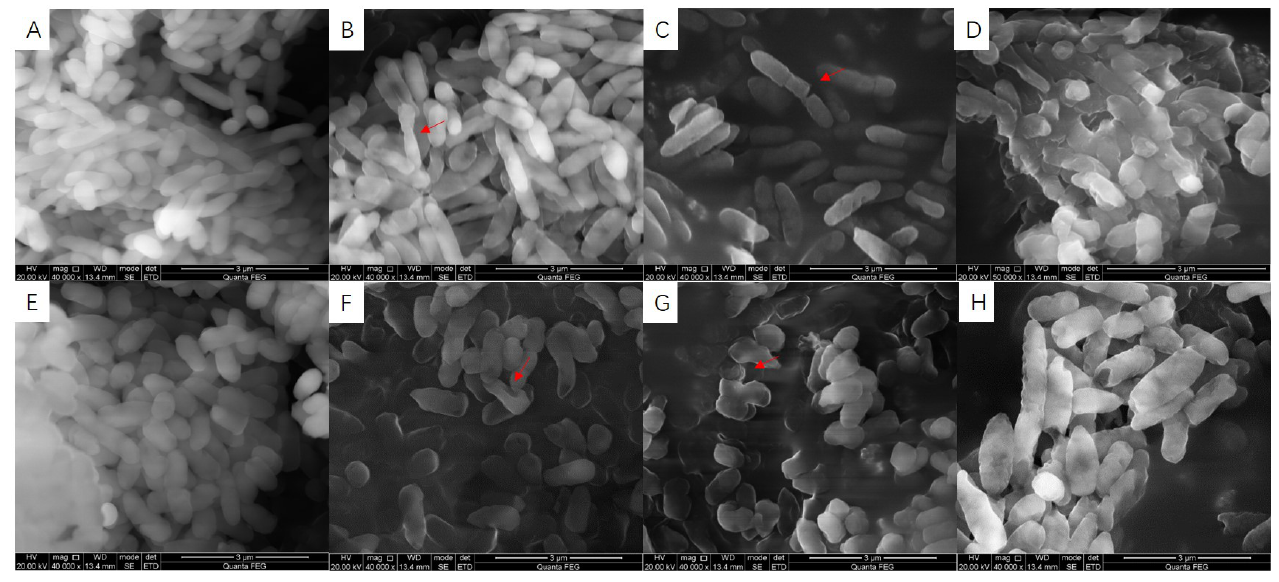
Figure 10. Antibacterial effects D. algida on biofilm appearance observed by SEM (40,000 × mag- nification) of the target Pseudomonas , where ( A – D ) are the blank control, 0.5 MIC, 1 MIC, 2 MIC, respectively, of P. fluorescens , while ( E – H ) are the blank control, 0.5 MIC, 1 MIC, 2 MIC, respectively, of P. fragi .